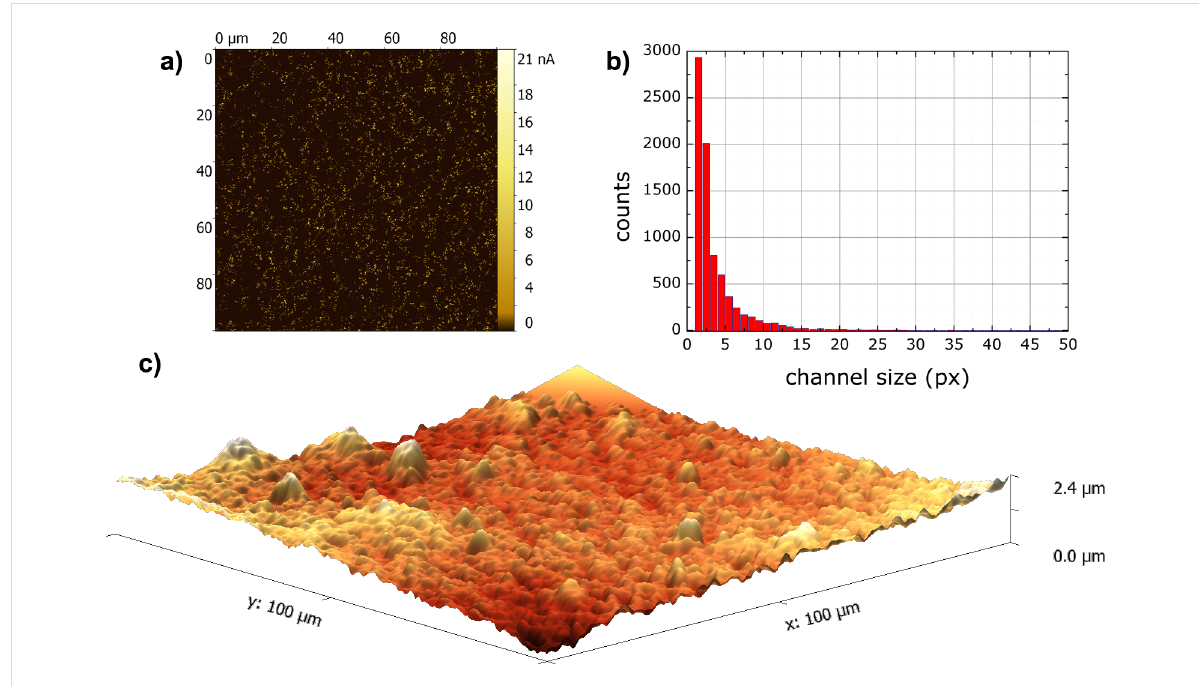
Figure 4: (a) Electroconductive map of CB channels of EVA–CB (7.75 phr CB) and (b) channel size distribution histogram; (c) surface AFM image.